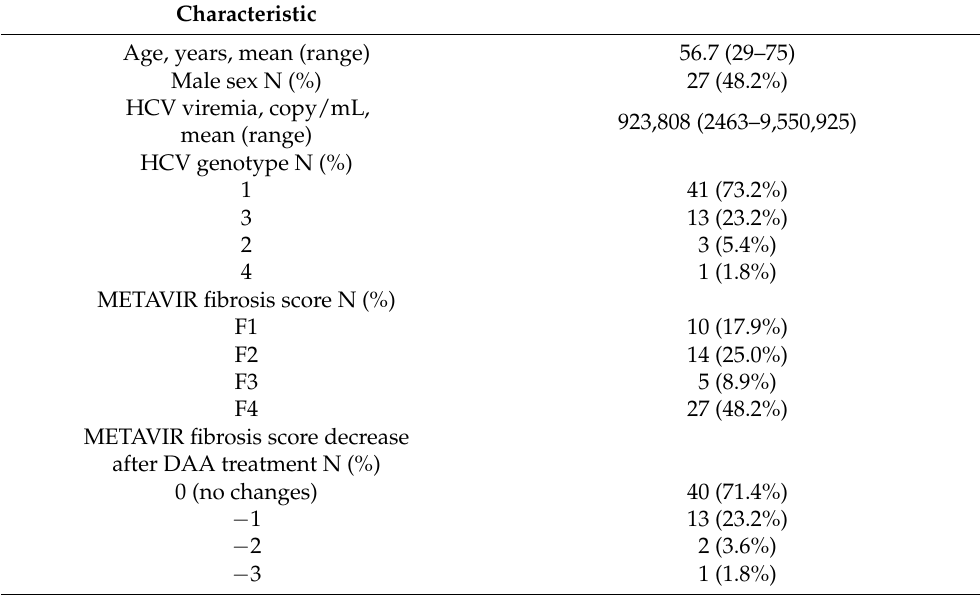
Table 1. Patients’ demographic and clinical